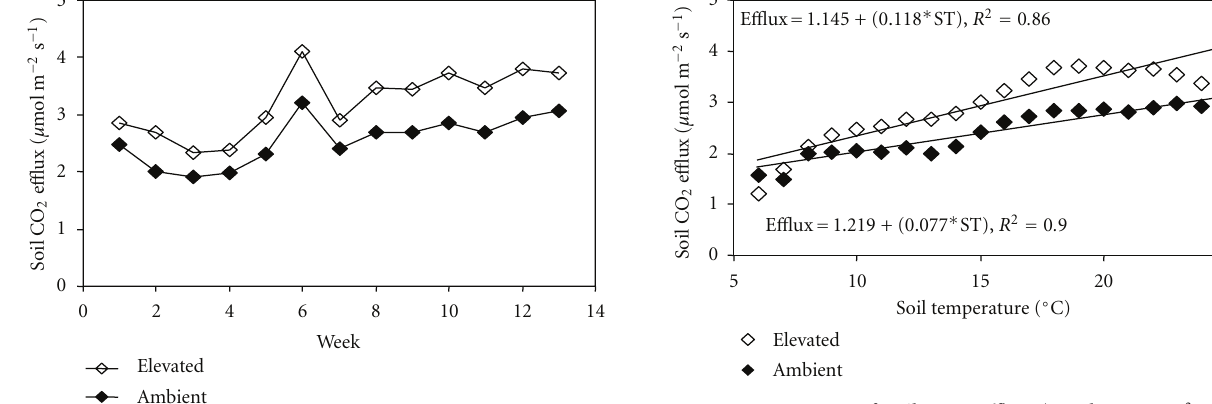
Figure 2: Response of soil CO 2 e ffl ux ( µ mol CO 2 m − 2 s − 1 ) to soil temperature for ambient (365 µ mol CO 2 mol − 1 ) and elevated (720 µ mol CO 2 mol − 1 ) CO 2 plots in a model regenerating longleaf pine-wiregrass ecosystem. Equations describing each line, with fit statistics, are provided above (elevated) and below (ambient) the